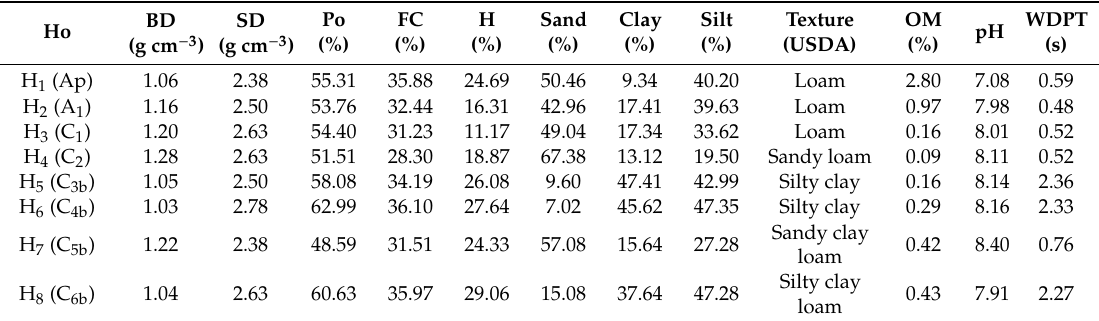
Table 1. Control soil horizons